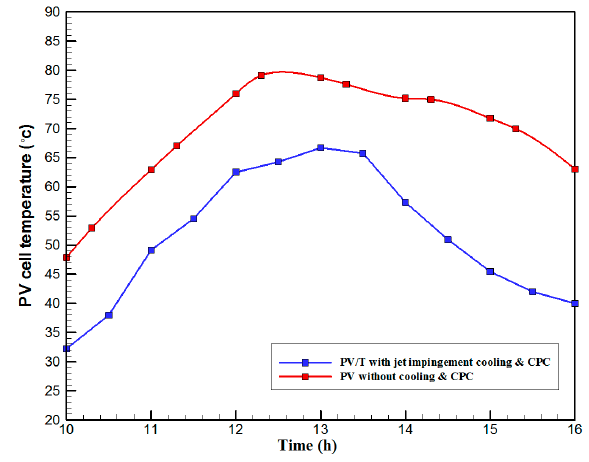
Figure 11. The hourly variation of the PV cell temperature for the PVT solar collector with CPC and the PV module without cooling and CPC.